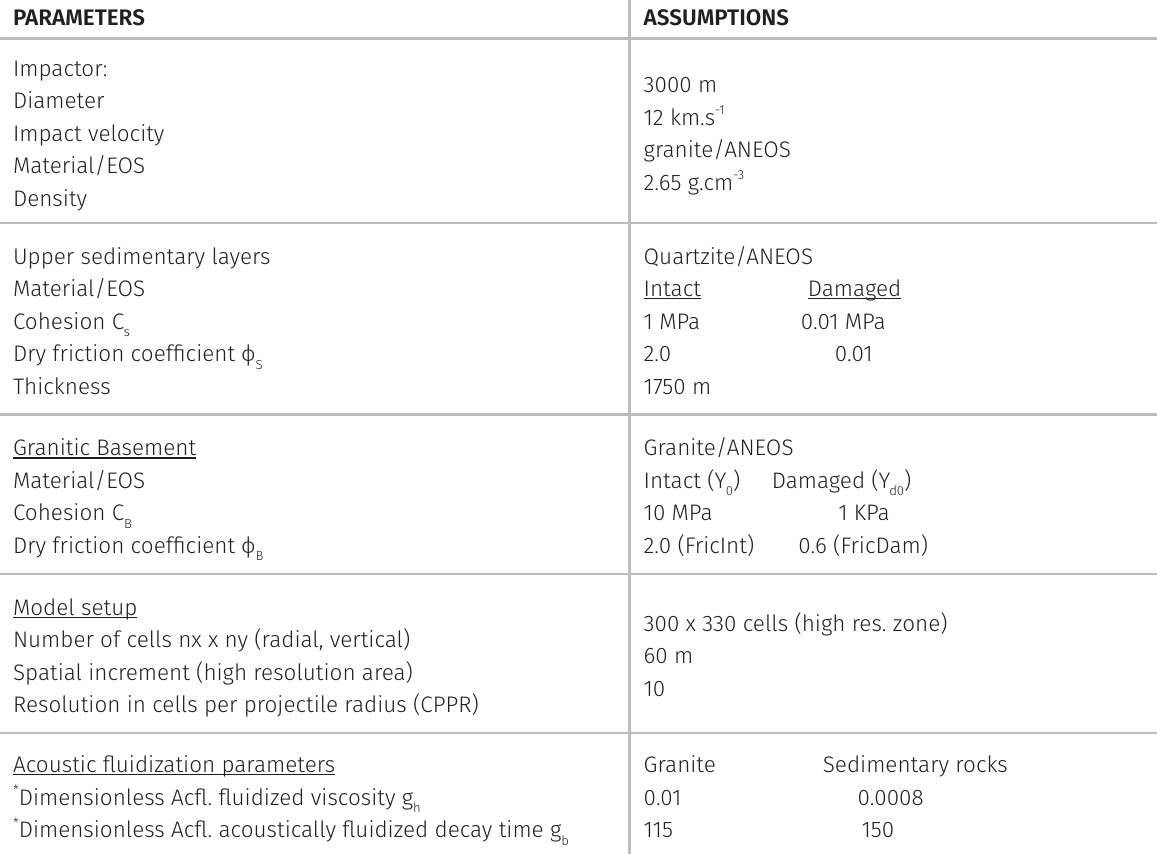
Table I. Parameters of the best fitting numerical model of the Araguainha impact structure. PARAMETERS